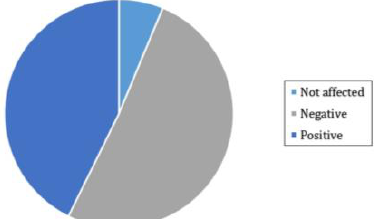
Fig. 4. Impact of bush encroachment on